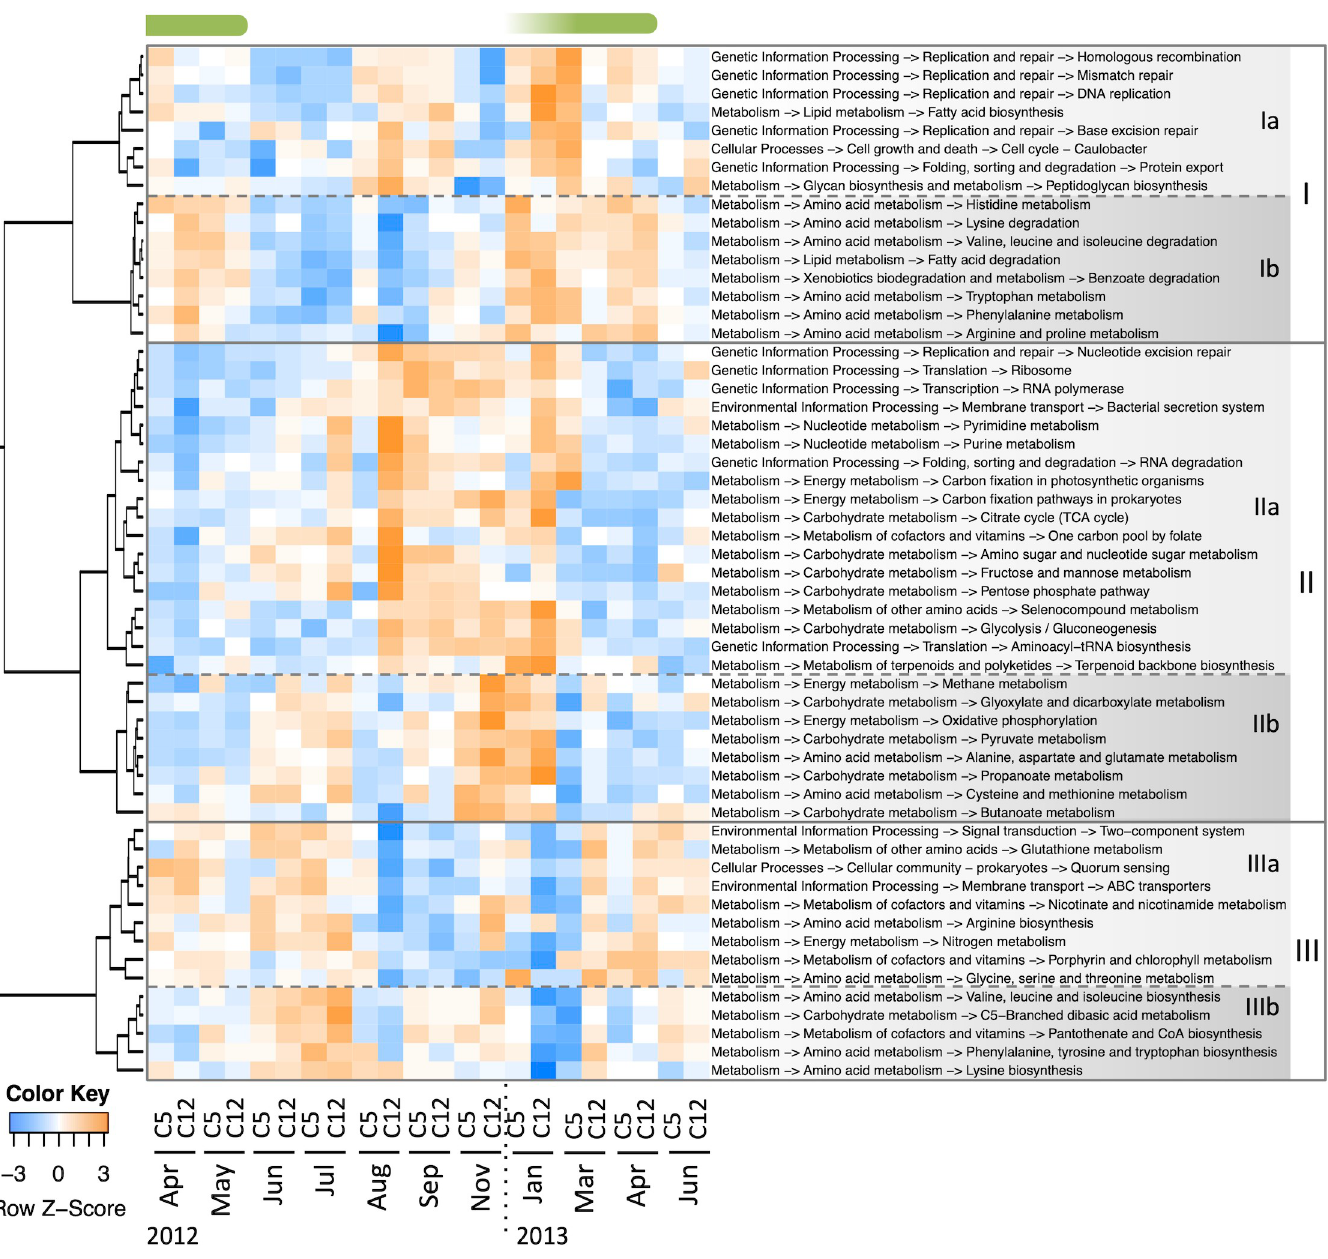
PLOS ONE | https://doi.org/10.1371/journal.pone.0257862 October 12,